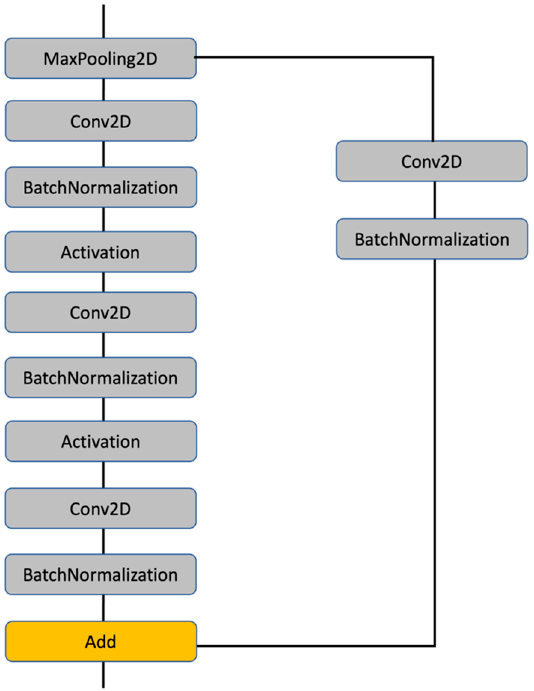
Figure 9. Partial illustration of ResNet50 architecture.